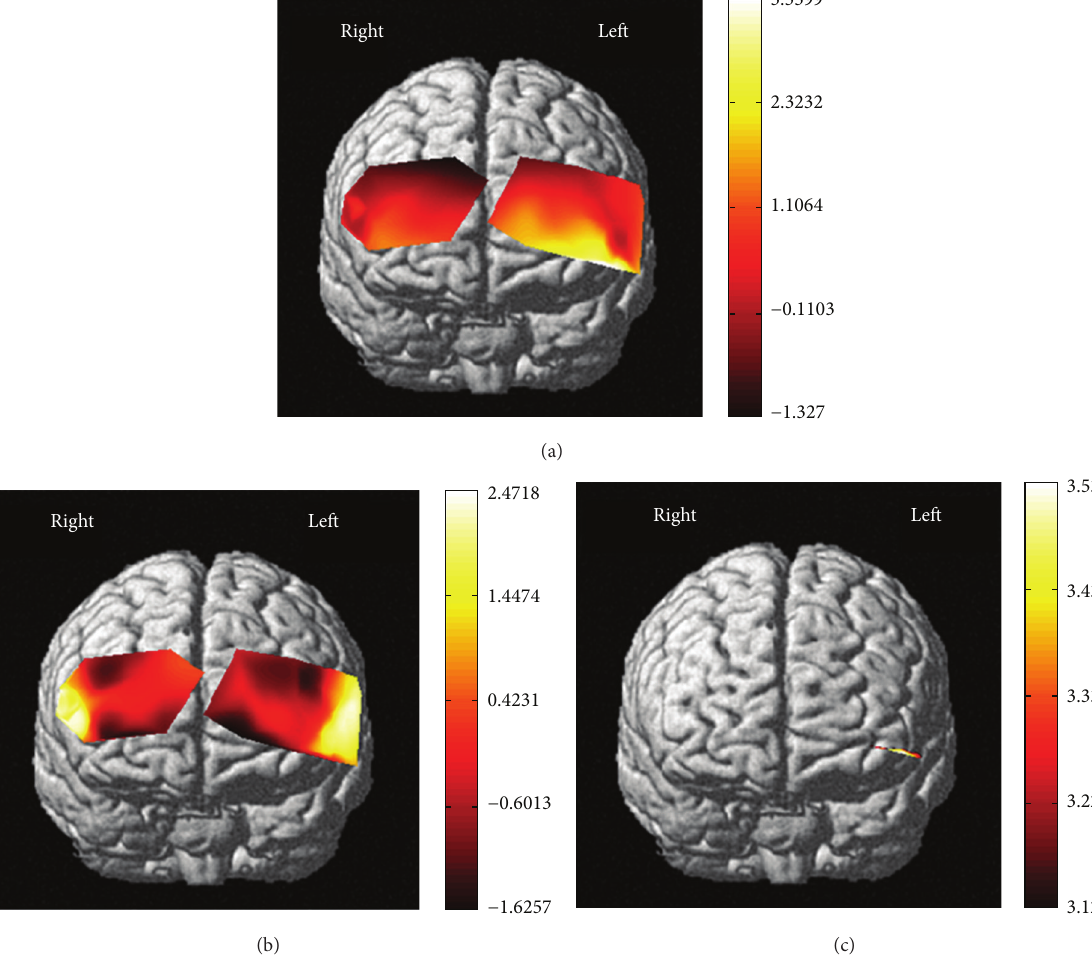
Figure 5: Group maps. 𝑡 -statistic maps from (a) HbO and (b) HbR obtained by group analysis. (c) Activation map from HbO found by group analysis using the LKC-based expected EC method (31 subjects, corrected 𝑃 -value <